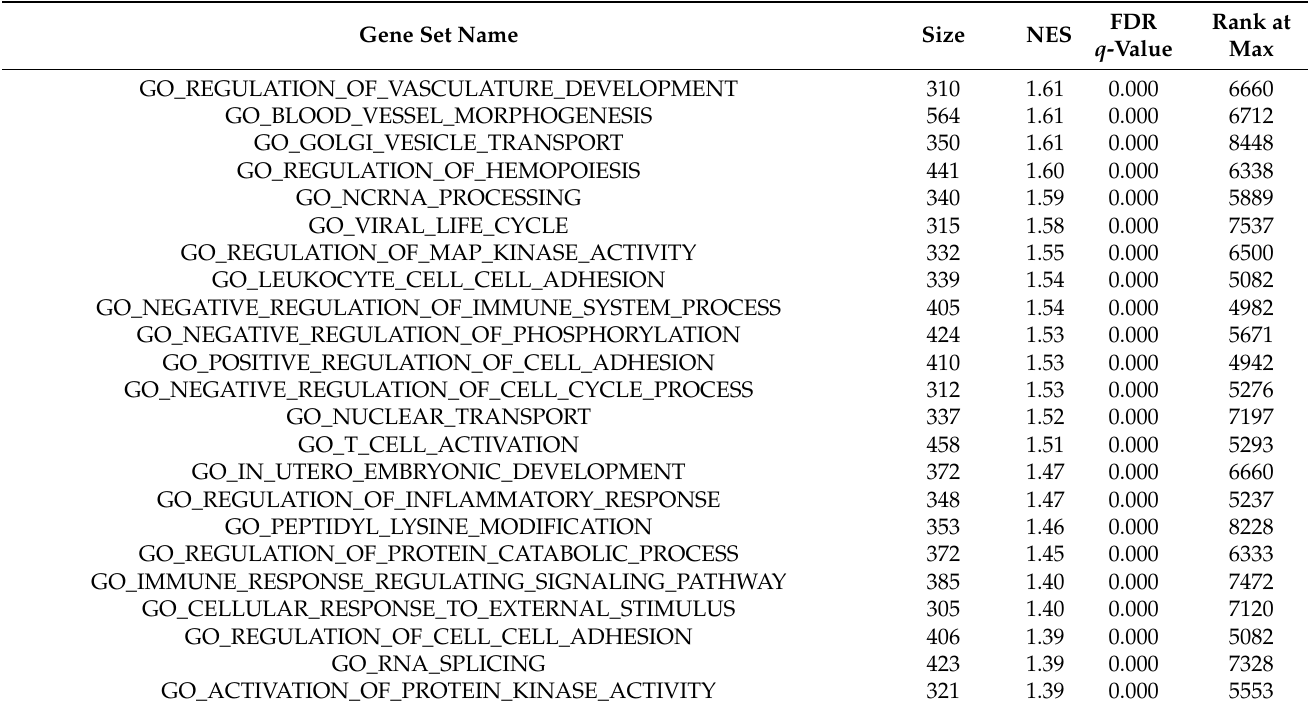
Table 2. Gene Ontology biological process terms (size > 300) that were significantly upregulated (FDR < 0.25) in the tunica media of the closing human DA tissues (Cases 2 and 3) compared to that of the patent DA tissue (Case